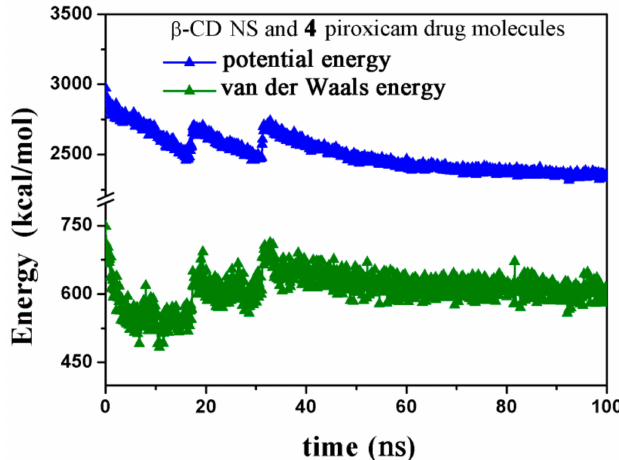
Figure 6. The potential energy and the van der Waals contribution calculated during the MD run for the NS model interacting with 4 piroxicam molecules.